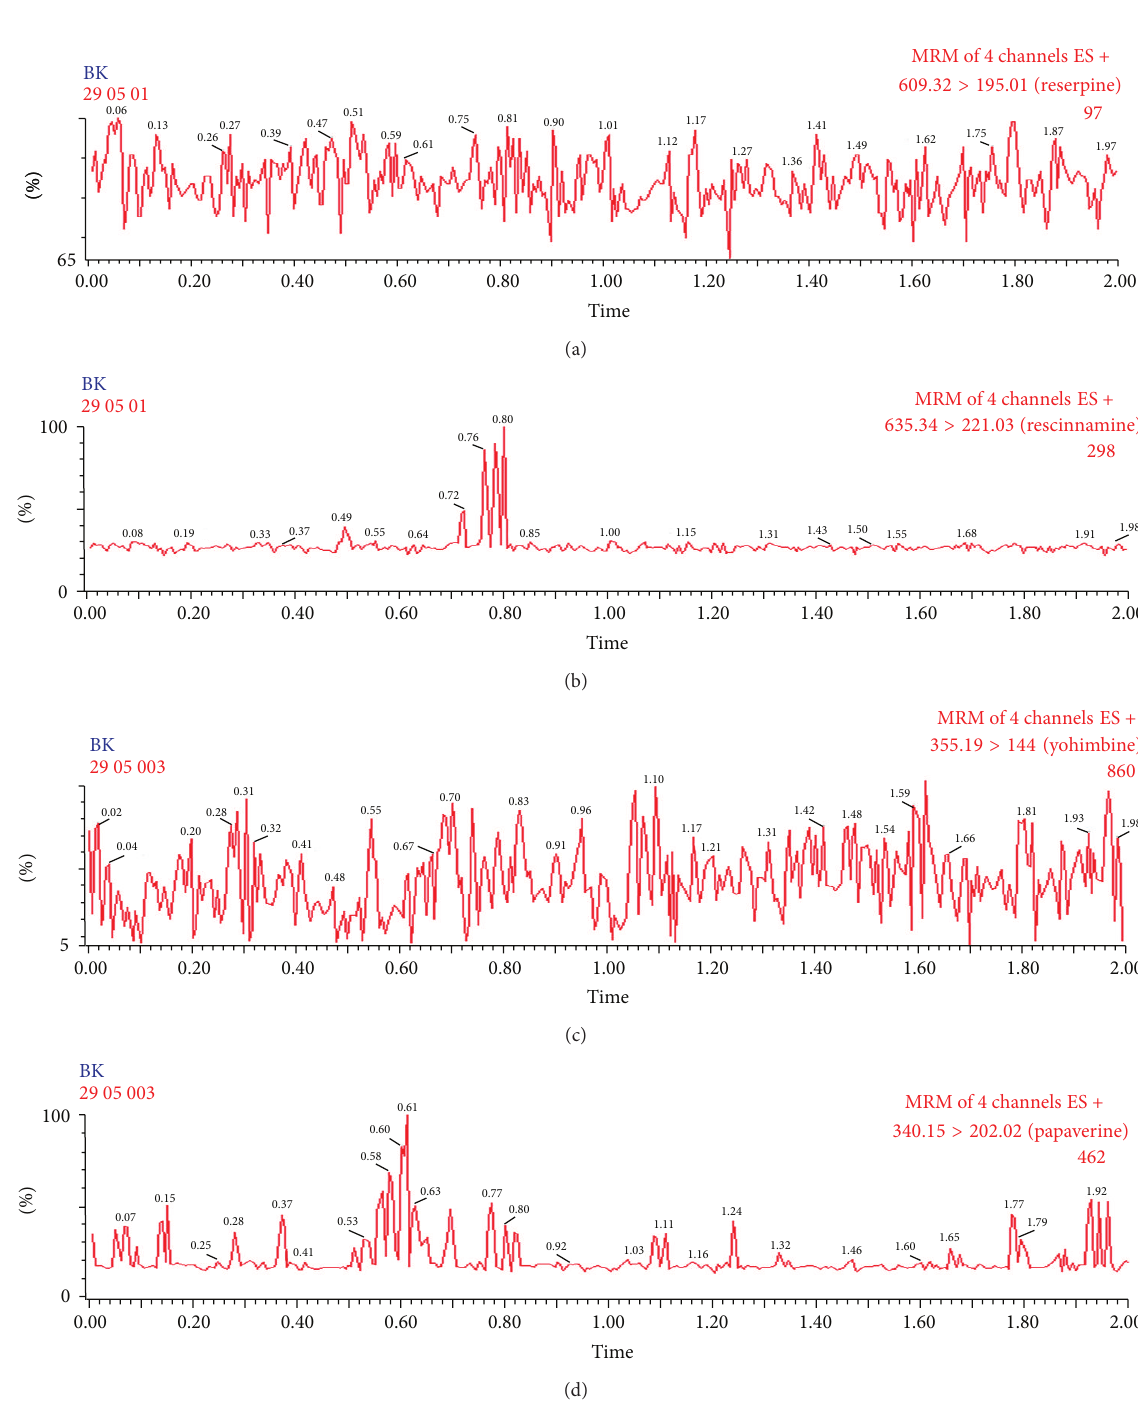
Figure 4: Representative MRM chromatograms of extracted blank plasma sample of reserpine (a), rescinnamine (b) yohimbine (c) and papaverine